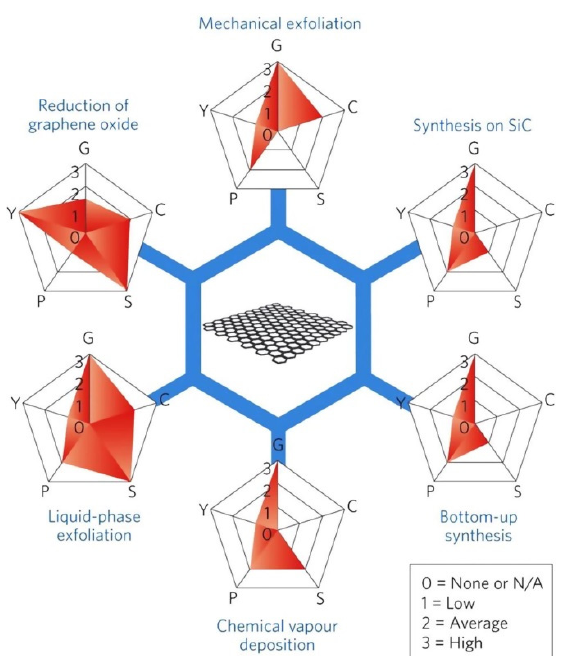
Figure 2. Graphene’s common production methods in a scale of 0–3. G refers to quality, S to scalability, P to purity, Y to yield of each route, and C to production cost (low value ⇔ high cost).